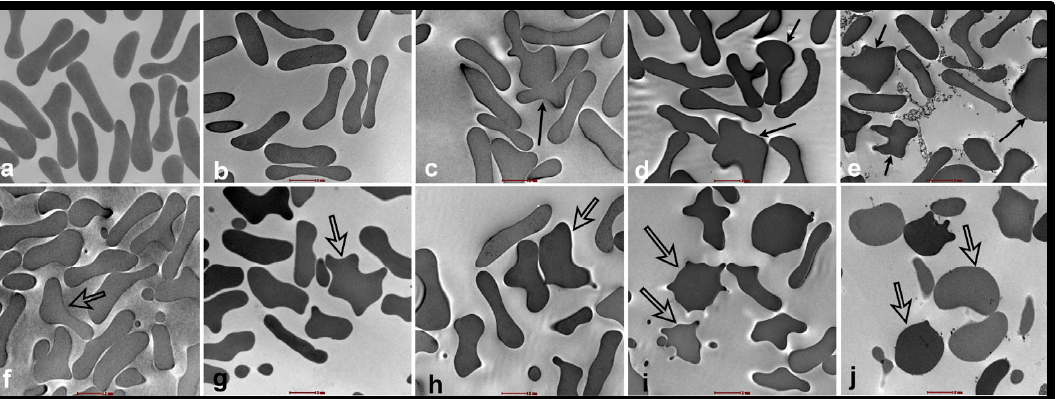
Figure 1. Transmission electron micrographs of the erythrocytes (RBCs) of normotensive (NT) (( a – e ): ( a ) NT ‐ saline; ( b ) NT 0.2; ( c ) NT 1:0; ( d ) NT 5.0; ( e ) NT 25 μ g/mL nanoparticles) and hypertensive (HT) (( f – j ): ( f ) HT ‐ saline; ( g ) HT 0.2; ( h ) HT 1:0; ( i ) HT 5.0; ( j ) HT 25 μ g/mL nanoparticles) rats after treatment with silica nanoparticles (SiNPs). Abnormal RBCs (thin arrows) were observed in NT rats after the addition of nanoparticles at a concentration of 1, 5 or 25 μ g/mL. In contrast, the RBCs of HT rats show abnormal shapes (empty arrows) even when treated with saline ( f ). The addition of nanoparticles increased the number of deformed RBCs. Scale bar = 2 μ m.